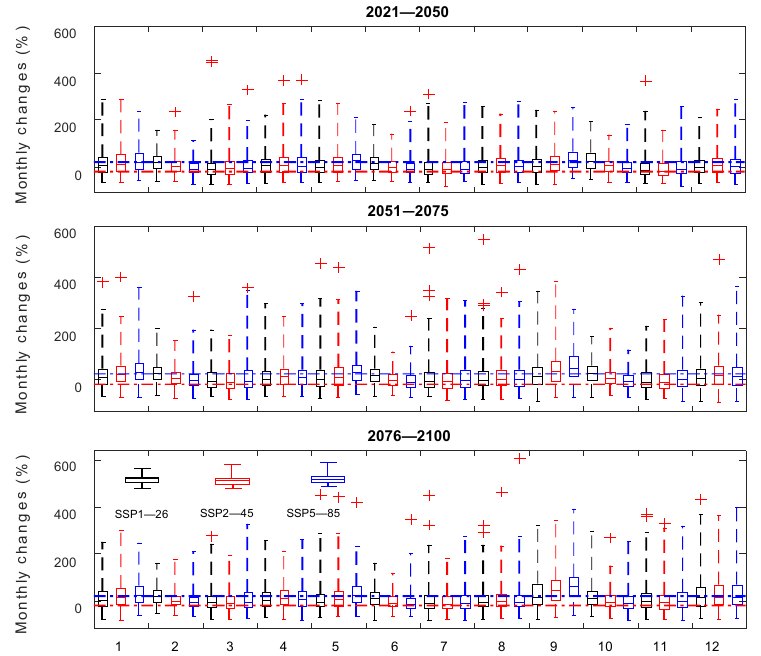
Figure 2. Projected change in monthly runoff (%) relative to the reference period for the near-, mid-, and long-term periods under the SSP1–2.6, SSP2–4.5, and SSP5–8.5 scenarios (red and blue lines represent − 20% and 20% of the reference value, respectively. The outliers are marked with red +.).